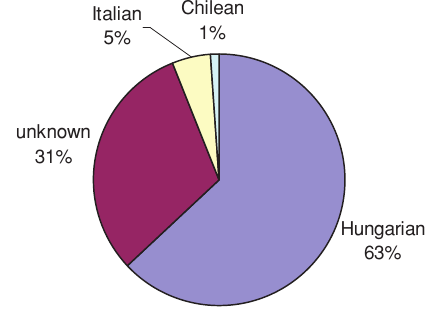
Figure 2. Origin of apples offered in the department stores Source : original calculation